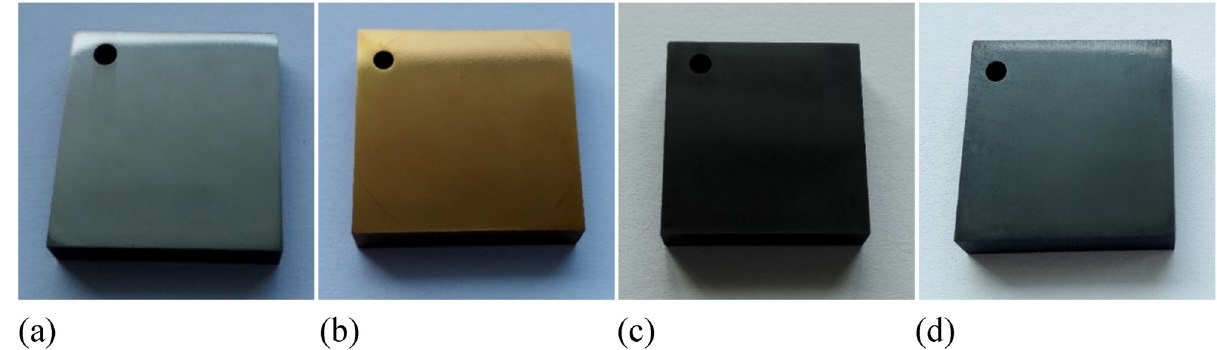
Figure 1: The prepared samples of ( a ) W 6 Mo 5 Cr 4 V 2 substrate, ( b ) TiN, ( c ) TiAlN, and ( d ) TiAlCrN coating on W 6 Mo 5 Cr 4 V 2